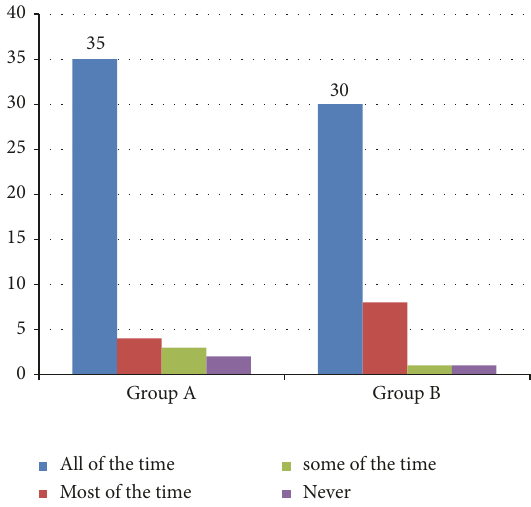
Figure 2: Compliance of the patients enrolled for the study.